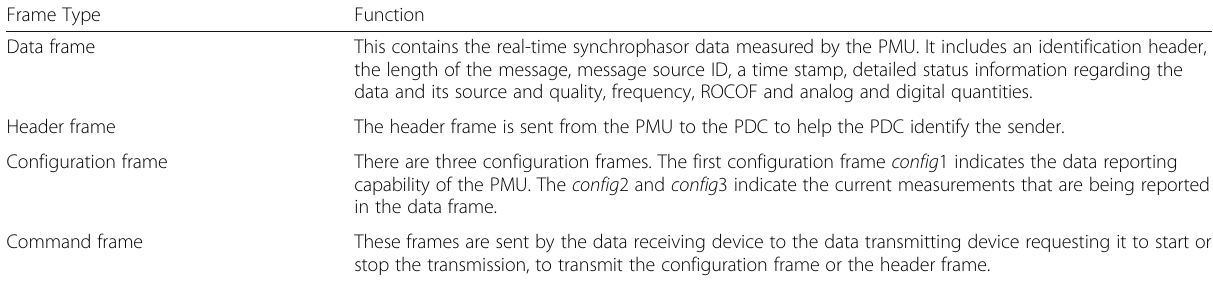
Table 3 Summary of the IEEE C37.118.2-2011 message frames Frame